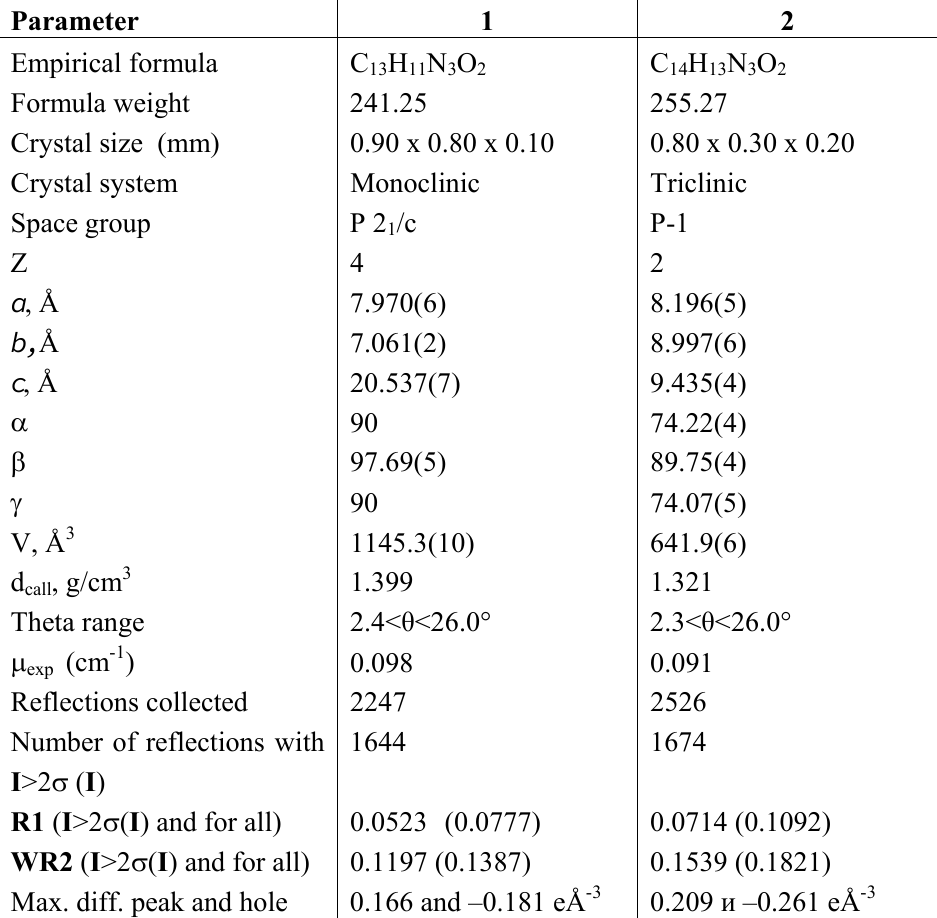
Table 2. Crystal data, experimental and refinement parameters for compounds 1 and 2